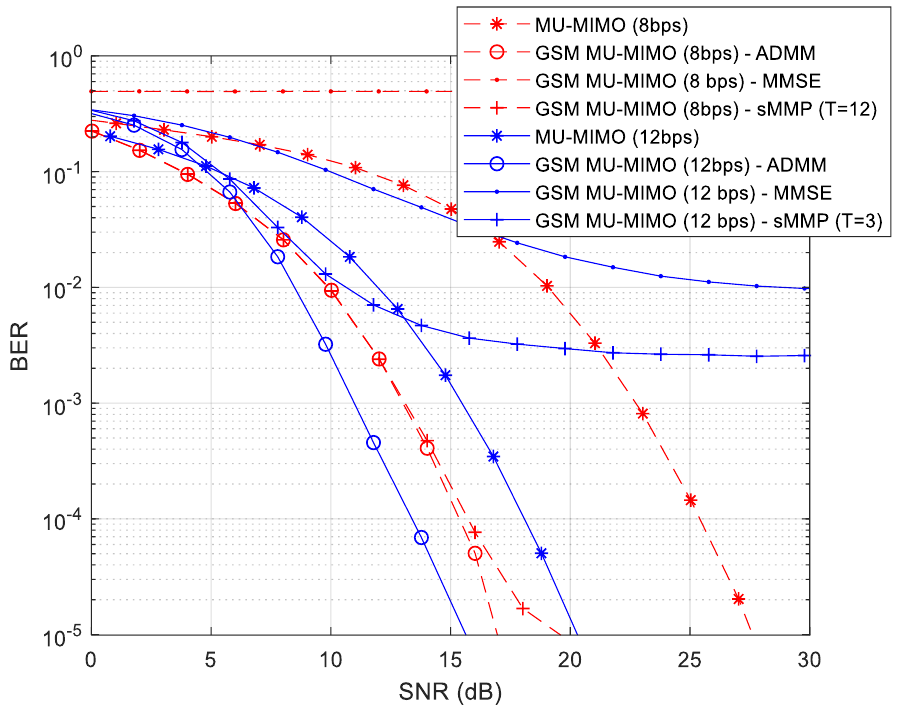
Figure 5. BER performance of a precoder based on GSM MU-MIMO and a precoder based on conventional MU-MIMO.